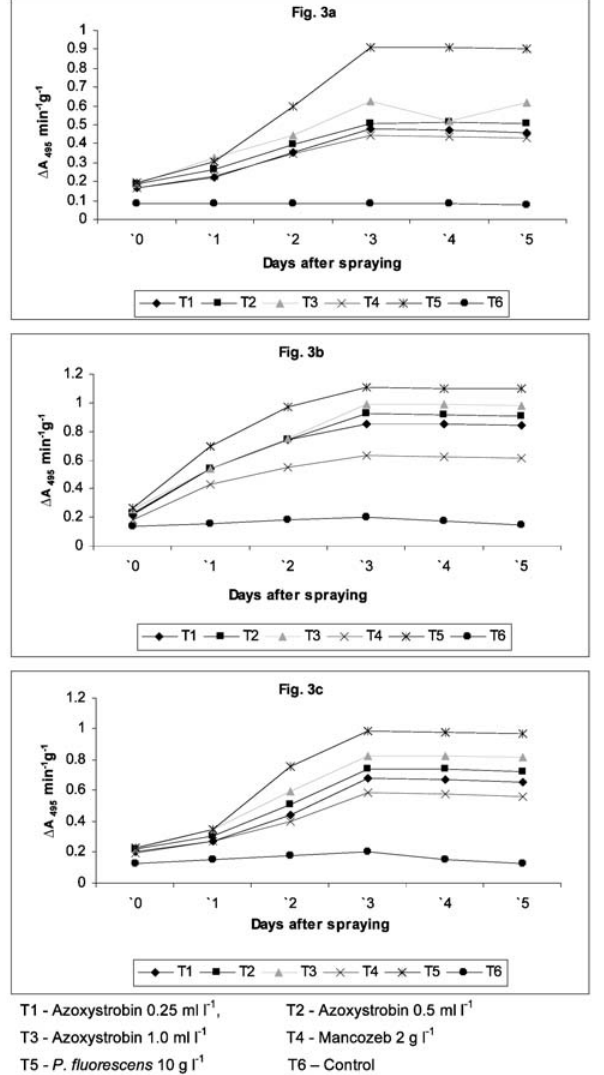
Fig. 3. Changes in PPO activity in cucumber plants: 3a, uninoculated and treated with azoxystrobin and Pseu- domonas fl uorescens ; 3b, challenge-inoculation of downy mildew pathogen; 3c, challenge-inoculation of powdery mildew